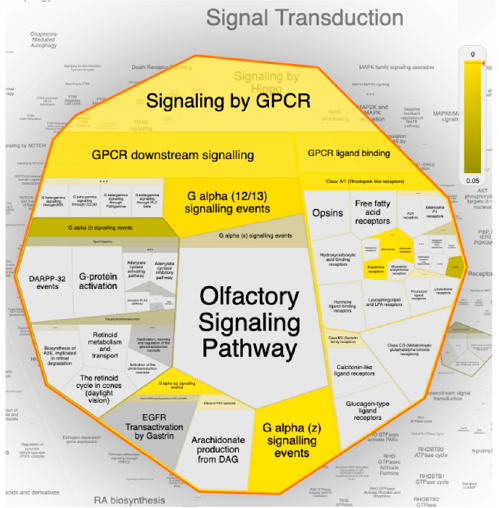
Figure 9. The Voronoi treemap of the top pathway (signal transduction) influenced by the top 20 gene targets in response to erylosides B (226) in term of SARS-CoV-2 infection. The color highlights the over-representation of that pathway in the input dataset. Light grey signifies pathways that are not significantly over-represented.